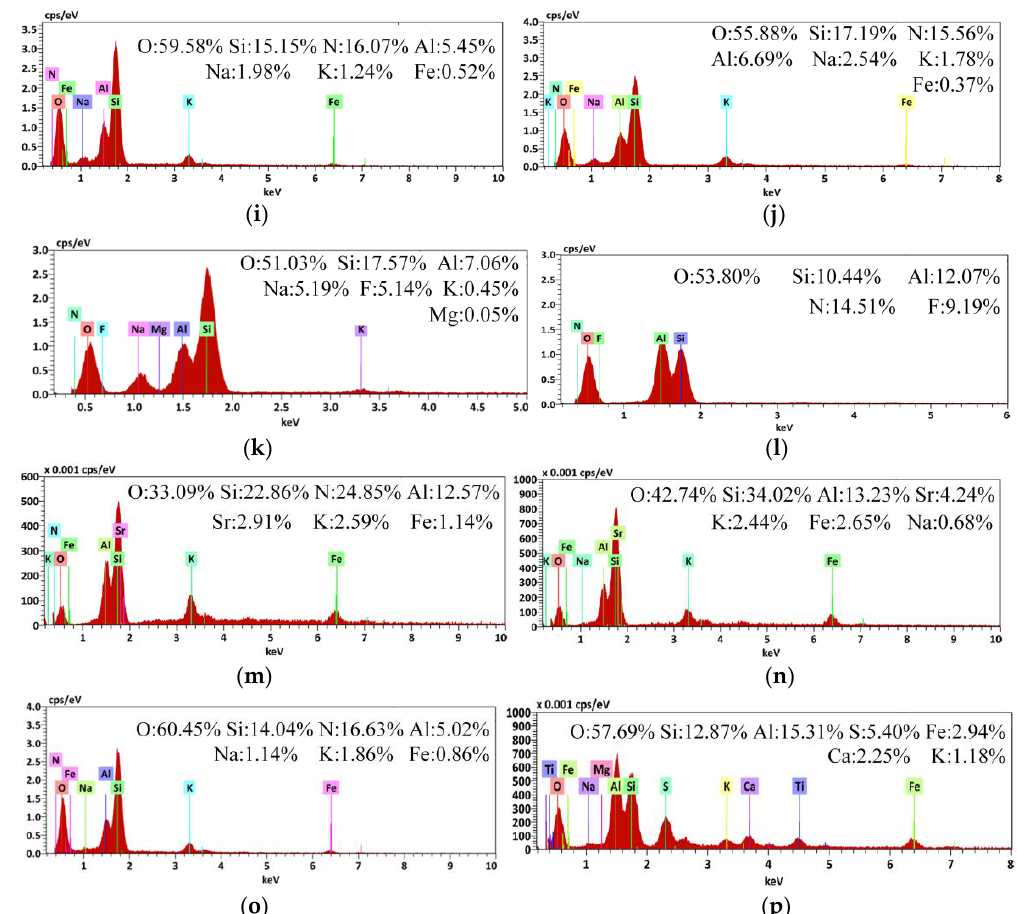
Figure 10. Scanning electron microscopy/energy-dispersive X-ray spectroscopy (SEM/EDS) diagram of Coal Gangue 1–4 before and after AMD repaired by dynamic experiment. ( a ) SEM diagram of Coal Gangue 1; ( b ) SEM diagram of Coal Gangue 2; ( c ) SEM diagram of Coal Gangue 3; ( d ) SEM diagram of Coal Gangue 4; ( e ) SEM diagram of Coal Gangue 1 after AMD repaired by dynamic experiment; ( f ) SEM diagram of Coal Gangue 2 after AMD repaired by dynamic experiment; ( g ) SEM diagram of Coal Gangue 3 after AMD repaired by dynamic experiment; ( h ) SEM diagram of Coal Gangue 4 after AMD repaired by dynamic experiment; ( i ) EDS diagram of Coal Gangue 1; ( j ) EDS diagram of Coal Gangue 2; ( k ) EDS diagram of Coal Gangue 3; ( l ) EDS diagram of Coal Gangue 4; ( m ) EDS diagram of Coal Gangue 1 after AMD repaired by dynamic experiment; ( n ) EDS diagram of Coal Gangue 2 after AMD repaired by dynamic experiment; ( o ) EDS diagram of Coal Gangue 3 after AMD repaired by dynamic experiment; ( p ) EDS diagram of Coal Gangue 4 after AMD repaired by dynamic experiment.